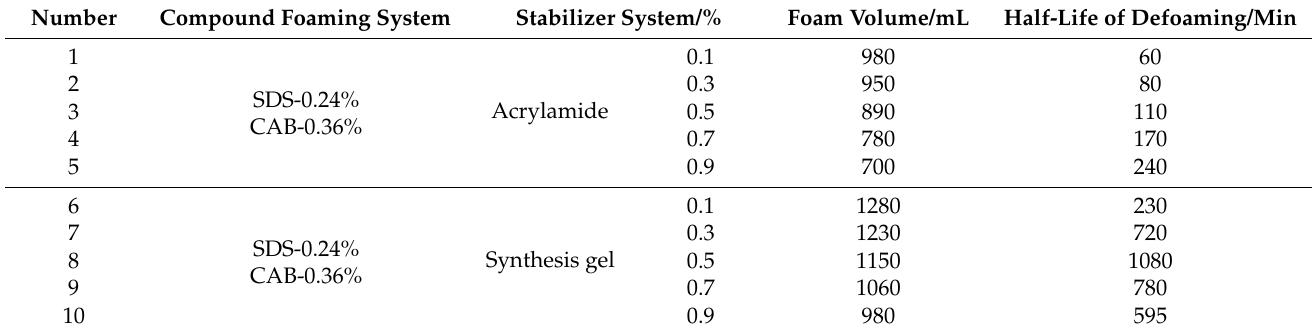
Table 4. Test results of foam stabilization performance.